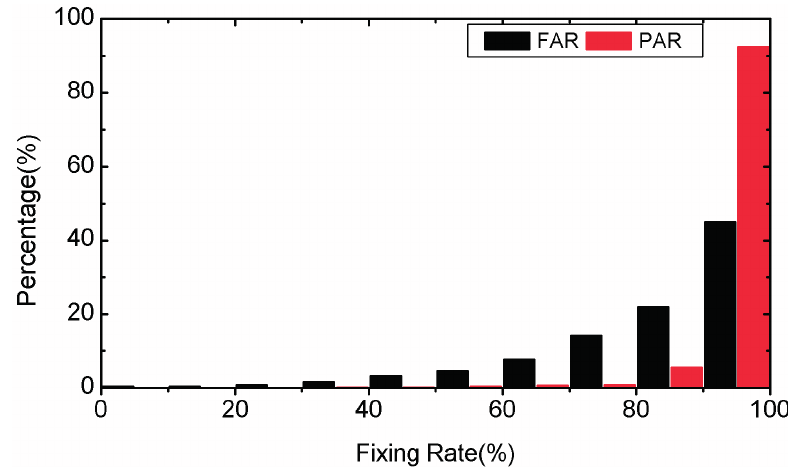
Figure 7. Distribution of fixing rate percentages of static PPP by employing FAR and PAR, respectively.